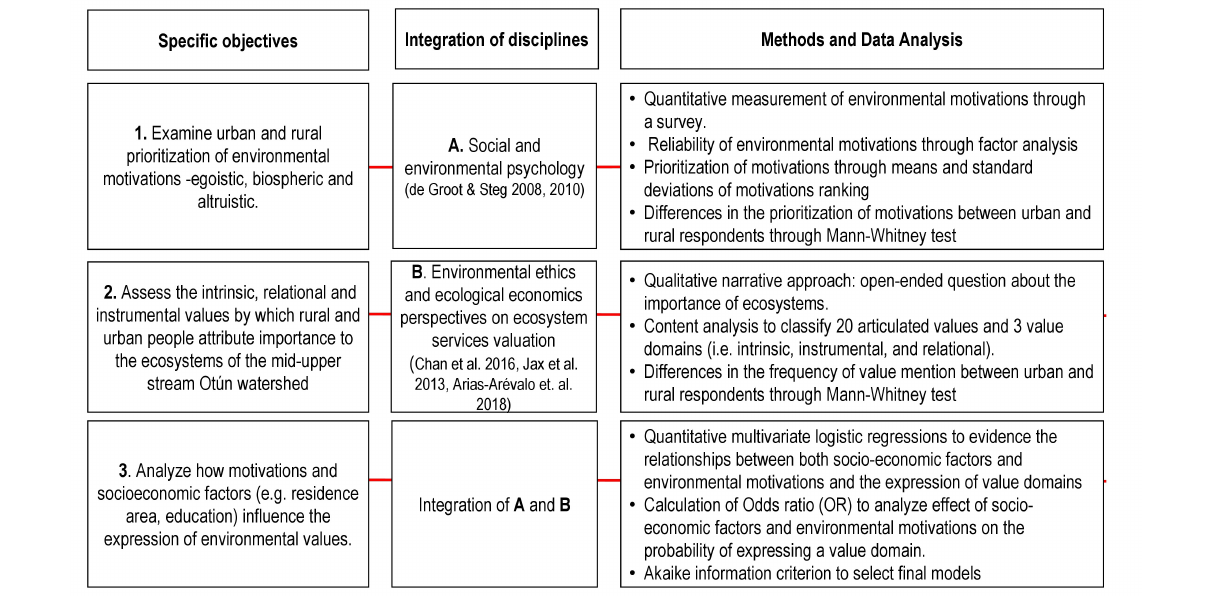
Fig. 1. Roadmap of the study, showing the link between specific objectives, disciplines, methods, and data